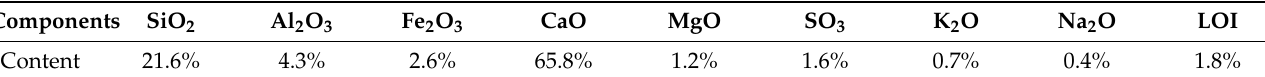
Table 2. Chemical components of the cement.